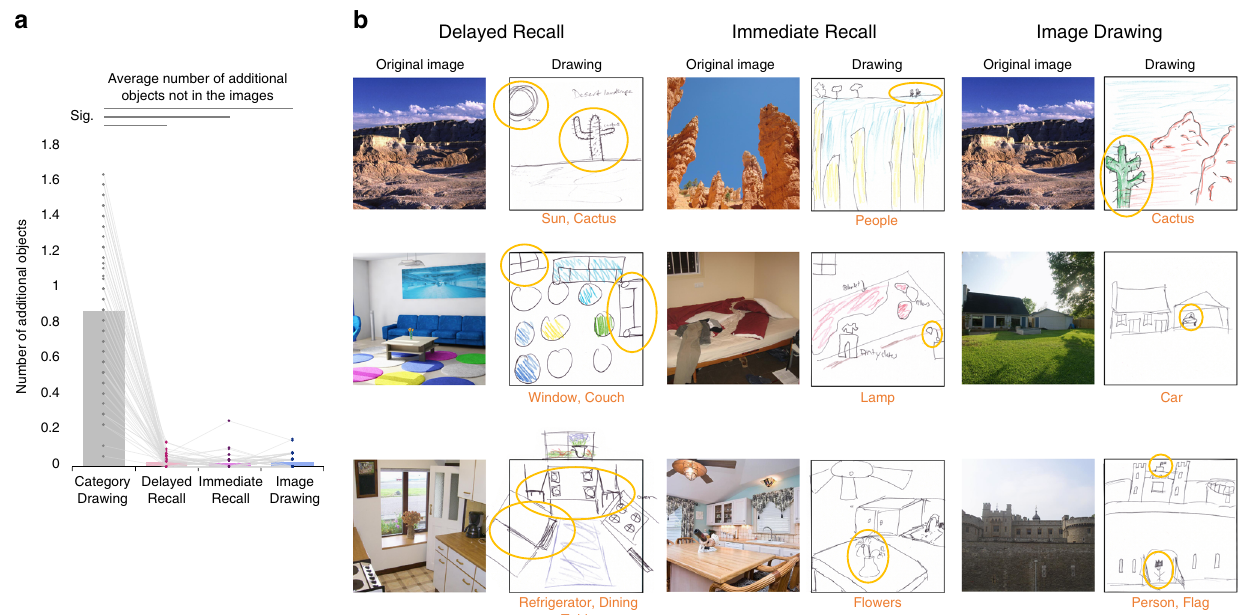
Fig. 3 Comparison of additional objects drawn beyond those in the images across conditions. a Average number of objects drawn for each drawing type that did not exist in the images (Category Drawing, Delayed Recall, Immediate Recall, Image Drawing). Participants drew few additional objects when recalling images regardless of delay and when drawing from the image. For Category Drawing, they often drew objects that did not exist in the images for that label, as expected since drawings were merely done from the category name. Dots represent each of the 60 images used in the experiment, with lines connecting the same image across conditions. Horizontal lines above the graph indicate signi fi cant pairwise Wilcoxon rank-sum test comparisons that pass a Bonferroni-corrected threshold of p < 0.0083. b Examples of additionally drawn objects from Delayed Recall, Immediate Recall, and the Image